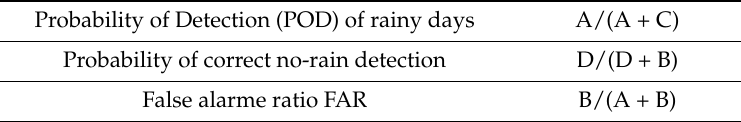
Table 3. Quantitative error metrics formulas. POD, PODno-rain and